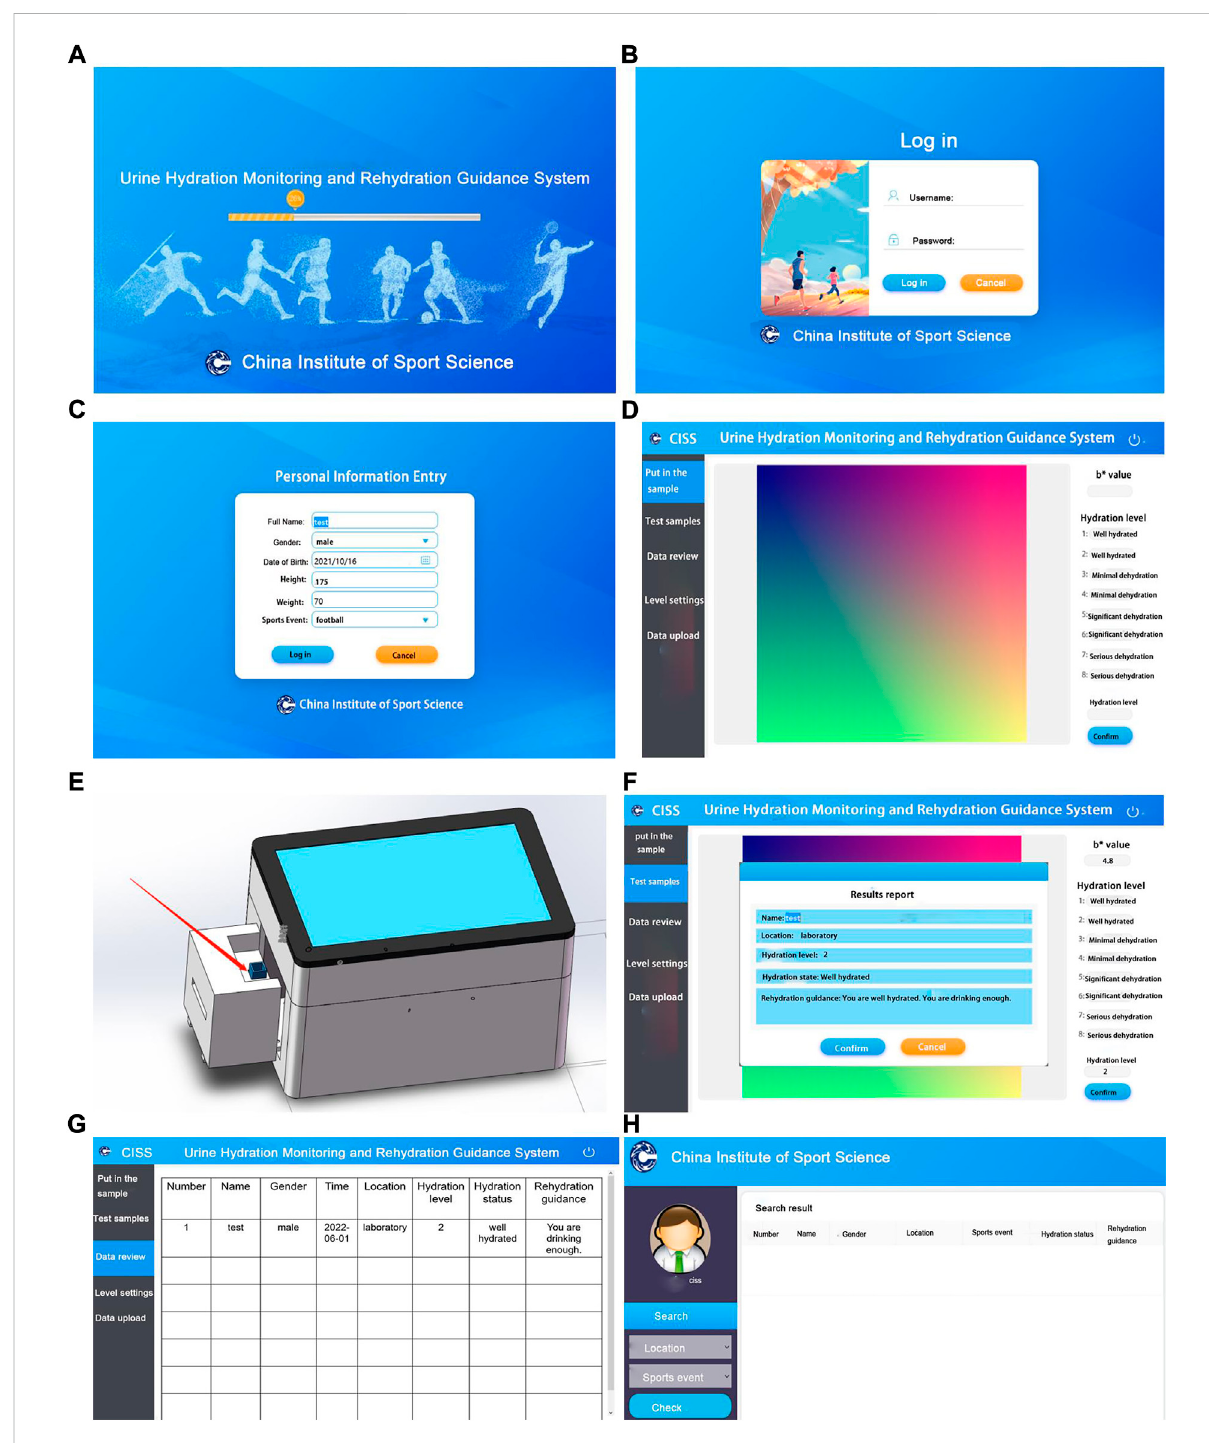
FIGURE 4 Schematic of the system interface and operation. (A) System entry interface, (B) login interface, (C) personal information entry interface, (D) sample insertion interface, (E) schematic of placing cuvette, (F) test sample and result report interface, (G) data upload and review interface, and (H) cloud data review